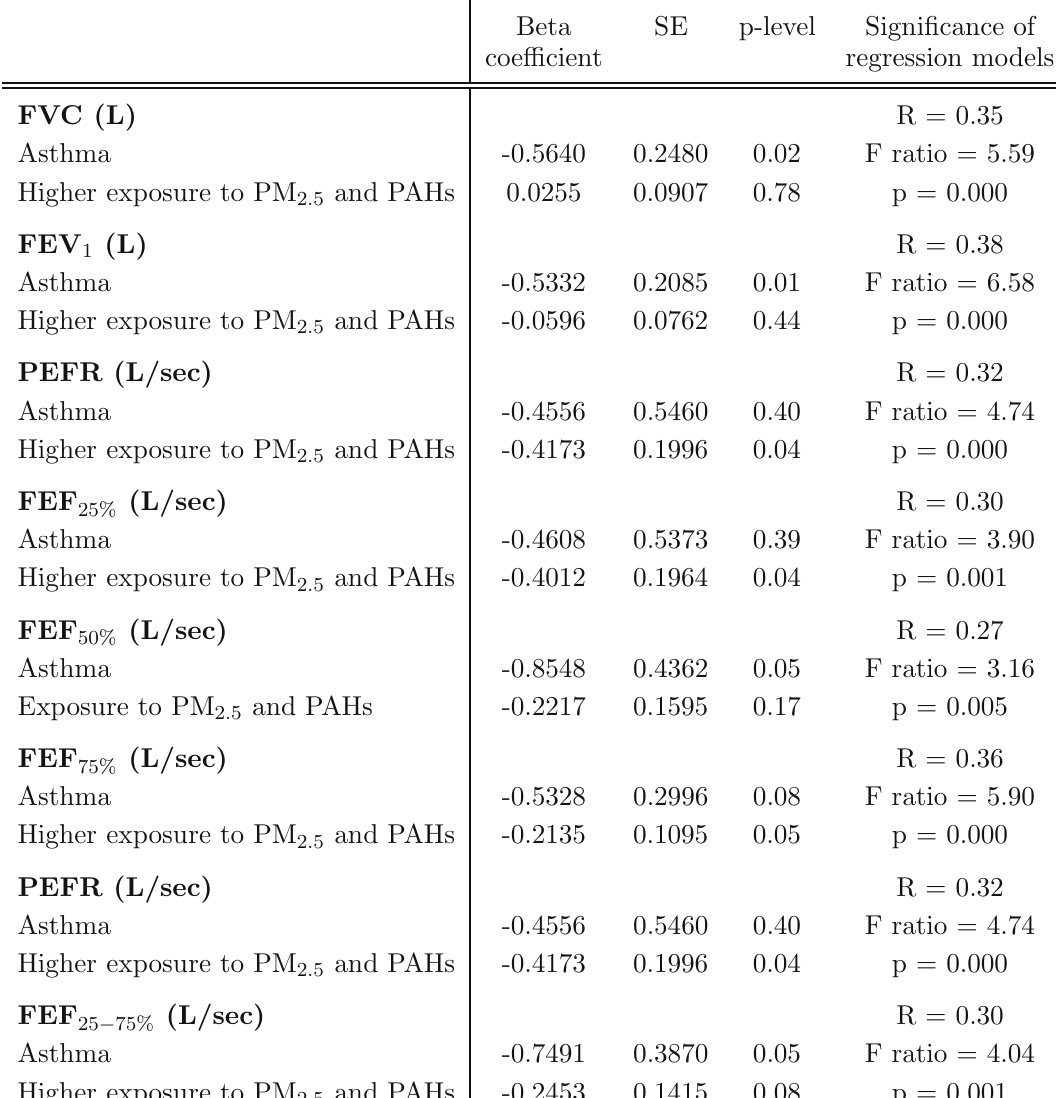
Table 4 Pulmonary function due to exposure levels of PM 2 . 5 ( > 34.3 µ g/m 3 ) and PAHs ( > 22.9ng/m 3 ), and asthma adjusted in multiple regression models to confounders and risk factors (age, height, weight, season